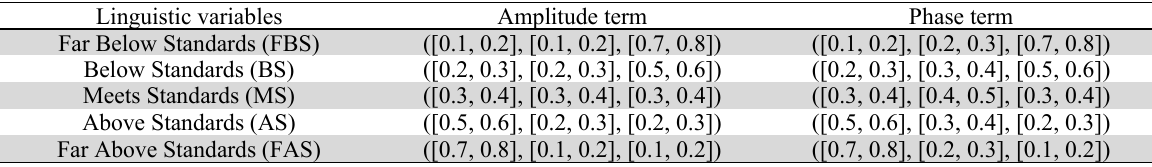
Linguistic variables for weighting importance based on interval complex neutrosophic values Linguistic